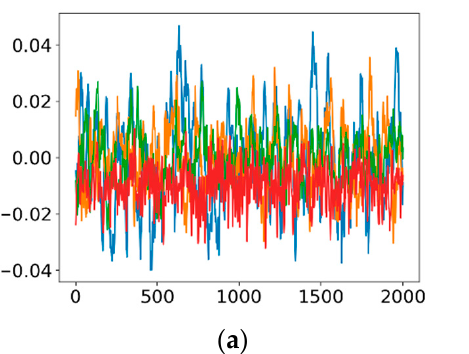
Figure 9. Fault detection results: ( a ) training data set and ( b ) testing data.